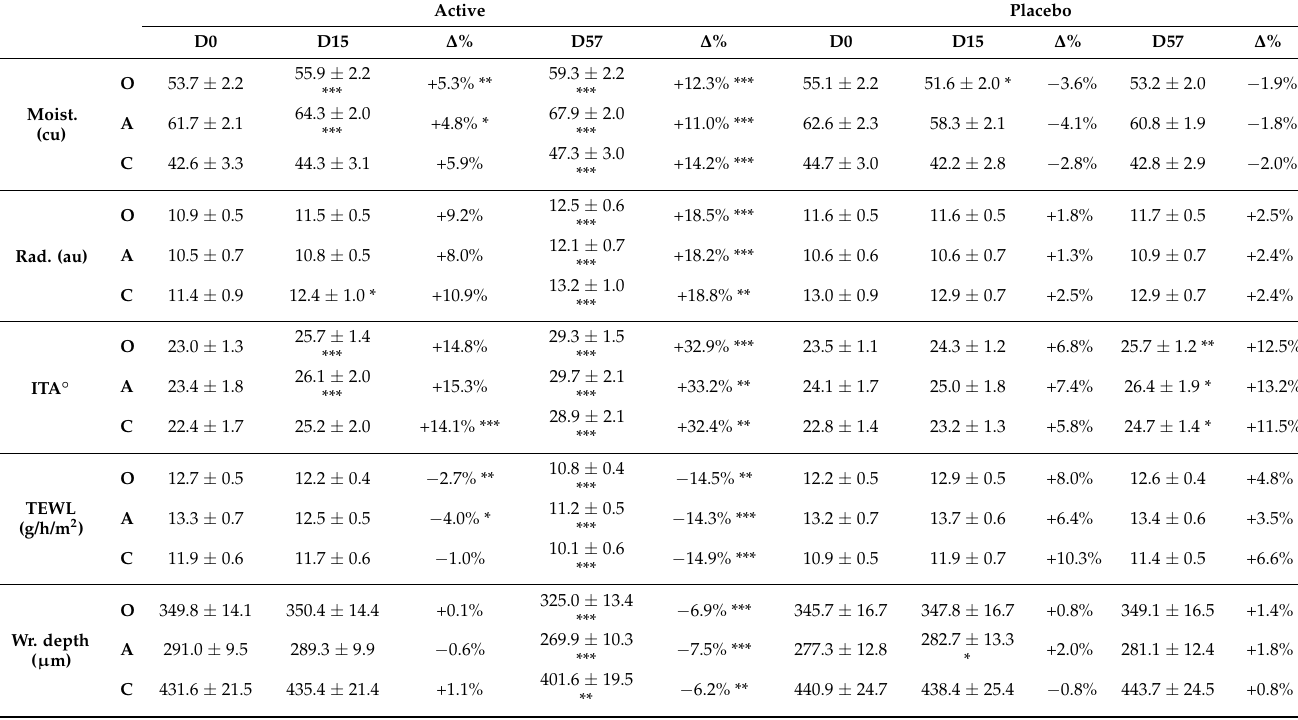
Table 2. Secondary endpoints results. The intragroup (vs. baseline) statistical analysis is reported near the raw data, while the intergroup (active vs. placebo) statistical analysis is reported near the % variation ( ∆ %). The statistical analysis is reported as follows: * p < 0.05, ** p < 0.01, and *** p < 0.005. Legend. D0, baseline; D14, follow-up visit after 15 days of product use; D57, follow-up visit after